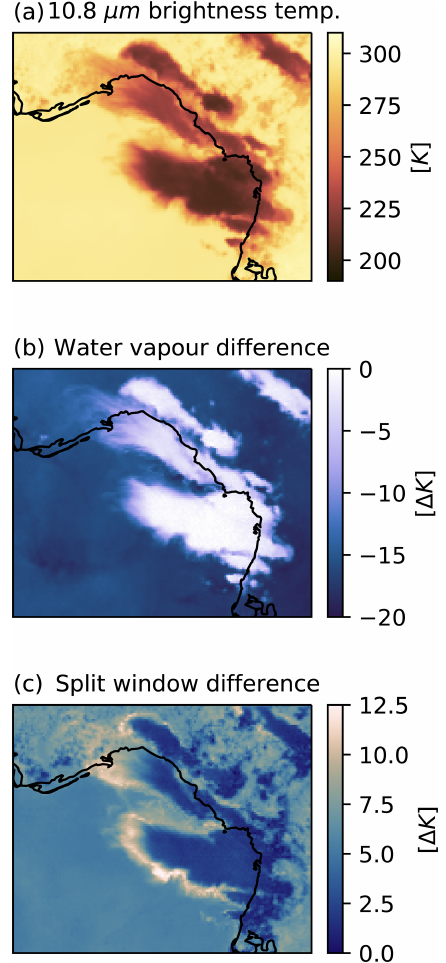
Figure 3. ABI channels and channel differences used with the de- tection and tracking algorithm. (a) The 10.8µm brightness temper- ature, or clean longwave window channel, which can differentiate clouds at all altitudes by their brightness temperature. (b) The water vapour difference (WVD) combination of the 6.2µm upper tropo- sphere water vapour channel minus the 7.3µm lower troposphere water vapour channel, which is strongly negative for clear sky and low cloud, but approaches positive values for thick, high clouds. (c) The split window difference (SWD) combination of the 10.8µm clean longwave window channel minus the 12.3µm dirty longwave window channel, which is near zero for thick clouds, around 5K for clear skies and approximately 10K for thin, ice